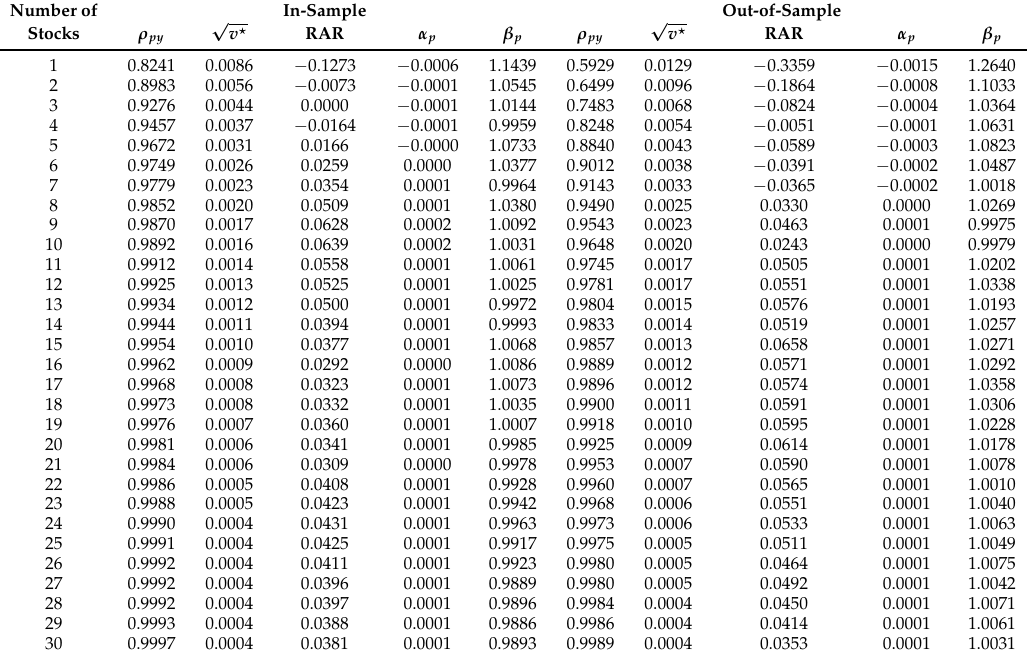
Table 1. Optimal tracking portfolios for DJIA index: Algorithm